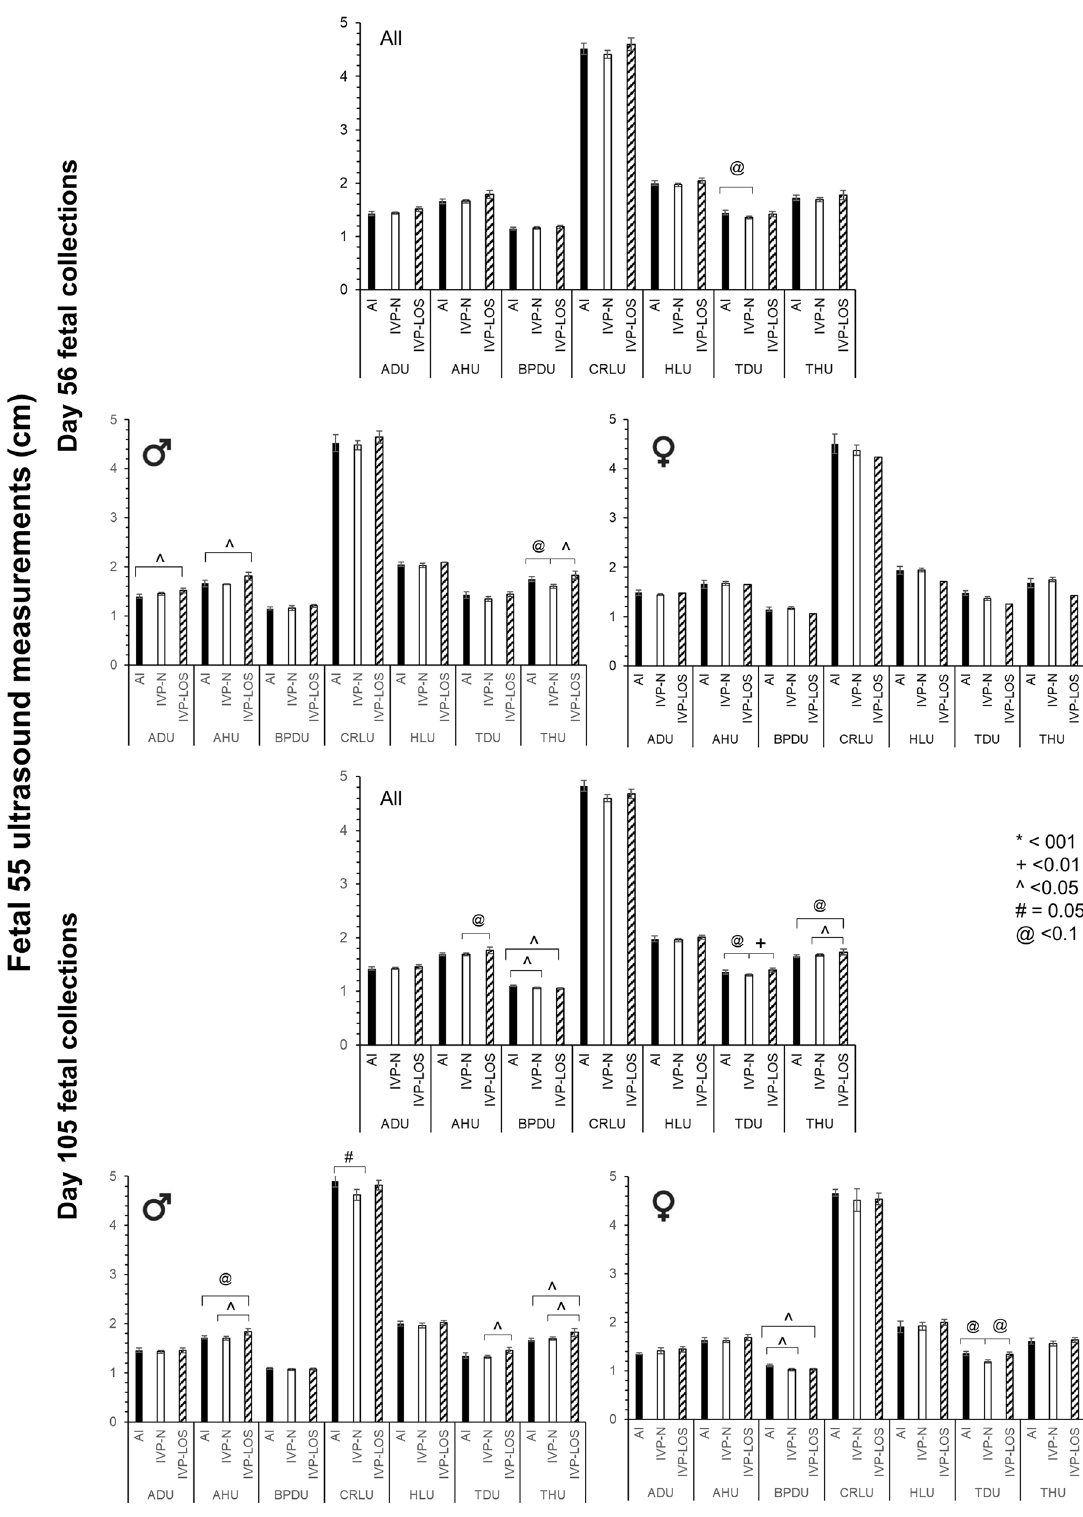
Figure 5. D55 fetal ultrasound measurements of fetuses collected on D55 and D105. Top three panels—D55 ultrasonographic measurements of fetuses collected on D56. n = 6 females and 8 males in the AI group and 22 females [1 LOS] and 21 males [8 LOS] in the IVP group. Bottom three panels—D55 ultrasonographic measurements of fetuses collected on D105. For each day set, the top graph includes both sexes and the bottom two graphs are separated by sex, males on the left and females on the right. n = 4 females and 8 males in the AI group and 13 [9 LOS] females and 33 males [8 LOS] in the IVP group. U ultrasound, AH abdominal height, AD abdominal diameter, BPD biparietal diameter, CRL crown rump length, HL head length, TD thoracic diameter, TH thoracic height. Data are represented as average ± SEM. For D56, there was only one female considered LOS, hence the lack of error bars. Lines going over three bars are used to represent statistical differences between the first and the third